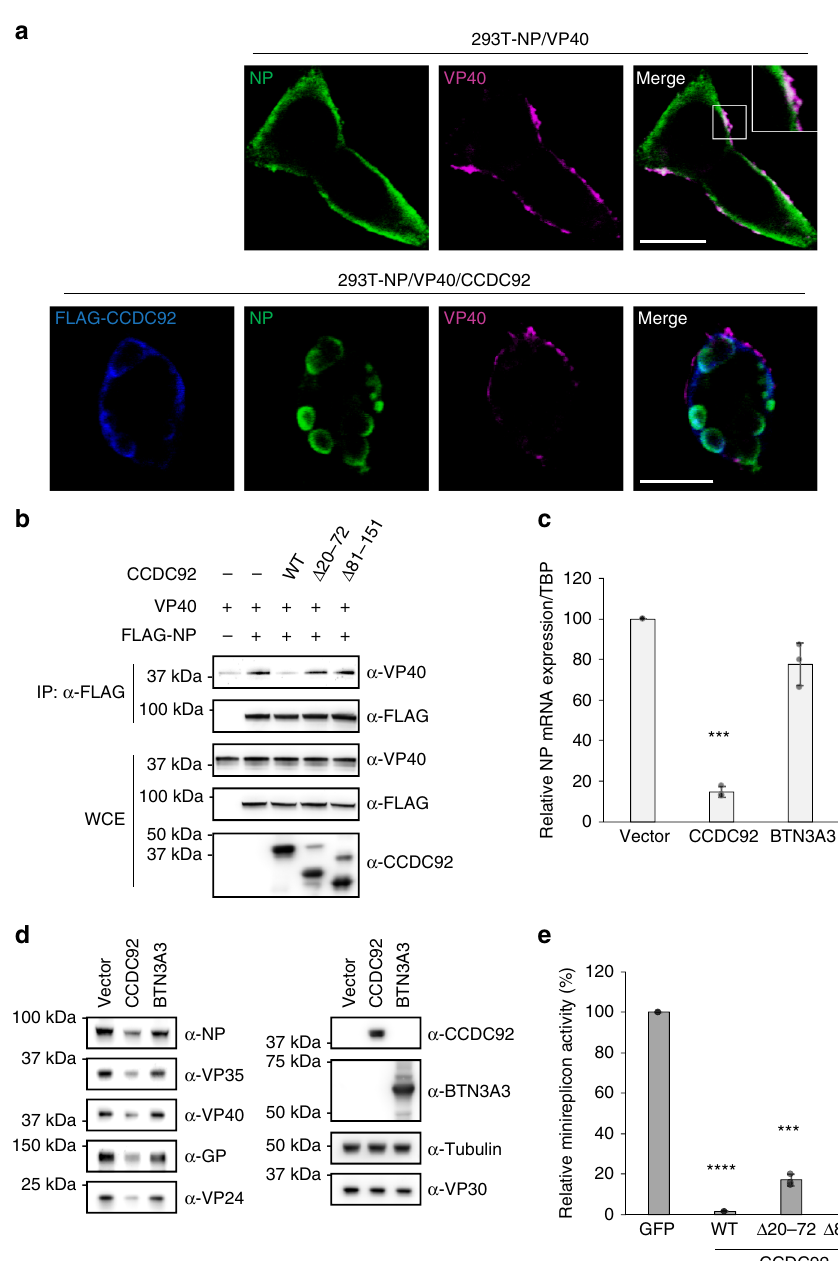
Fig. 5 Inhibition of the NP – VP40 interaction and viral transcription by CCDC92. a EBOV NP (green) and VP40 (magenta) with or without CCDC92 (blue) in HEK-293T cells transfected with expression vectors for NP and VP40 together with or without FLAG-CCDC92 were visualized with speci fi c antibodies and analyzed by confocal microscopy. The inset is the enlarged image corresponding to the boxed area. Data are representative of two independent experiments. Scale bars, 20 μ m. b Interaction between NP and VP40 in the presence of CCDC92 or its deletion mutants in HEK-293T cells transfected with the indicated combination of expression vectors. Cell lysates were immunoprecipitated with anti-FLAG antibody followed by immunoblotting. Data are representative of three independent experiments. IP, immunoprecipitation. WCE, whole-cell extract. c Relative EBOV NP mRNA expression in HEK-293T cells after overexpression of CCDC92 or BTN3A3. Cells were transfected with expression vectors for CCDC92 or BTN3A3, or with an empty control vector for 24 h prior to infection with EBOV Δ VP30 at an MOI of 3.0. At 24 h post infection, RNA was extracted and then quanti fi ed by qRT-PCR. The results are normalized to TBP mRNA expression, and the data are presented as percentages ± SD ( n = 3). (*) indicates a statistically signi fi cant difference ( p -values of two-tailed Student ’ s t -tests; *** p < 0.001) from the control. d Cells were transfected and infected as described in c . At 24 h post infection, cells were lysed and the indicated protein expression levels were analyzed by immunoblotting. e Relative luciferase activity in HEK- 293T VP30 cells after transfection for 48 h with vectors required for the minireplicon assay, each of the indicated genes, and an internal Renilla luciferase control vector. Data are presented as means ± SD, and are representative of three independent experiments. (*) indicates a statistically signi fi cant difference ( p- values of two-tailed Student ’ s t -tests; *** p < 0.001, **** p < 0.0001) from the control. Source data are provided as a Source Data fi